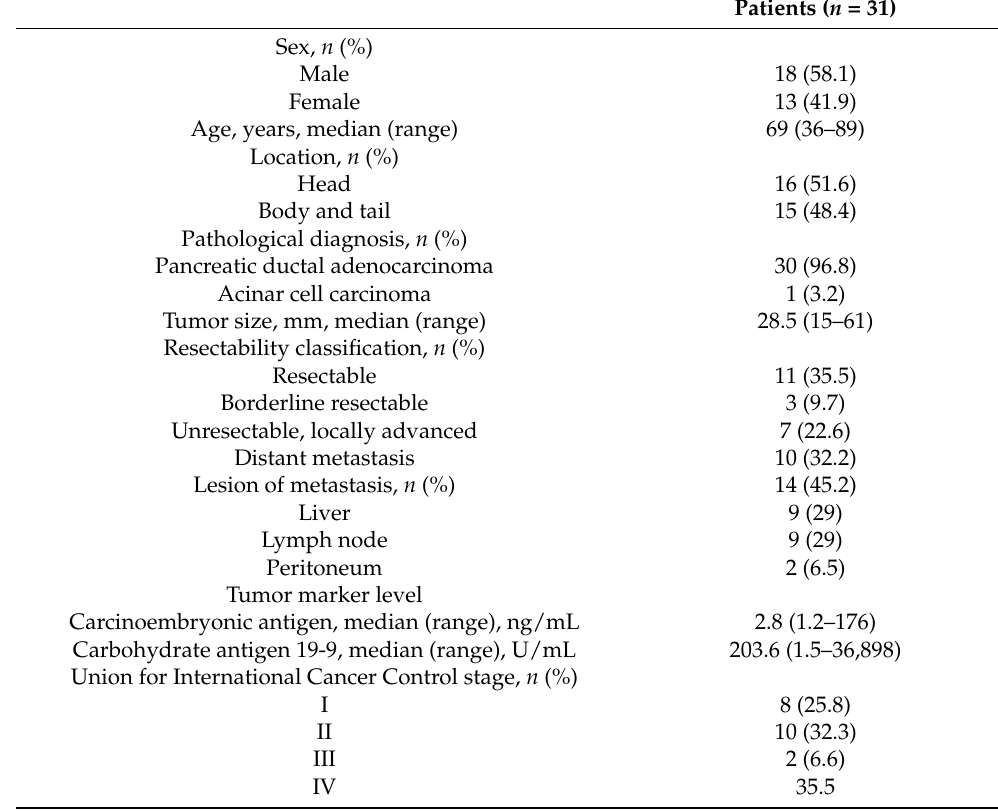
Table 1. Patient